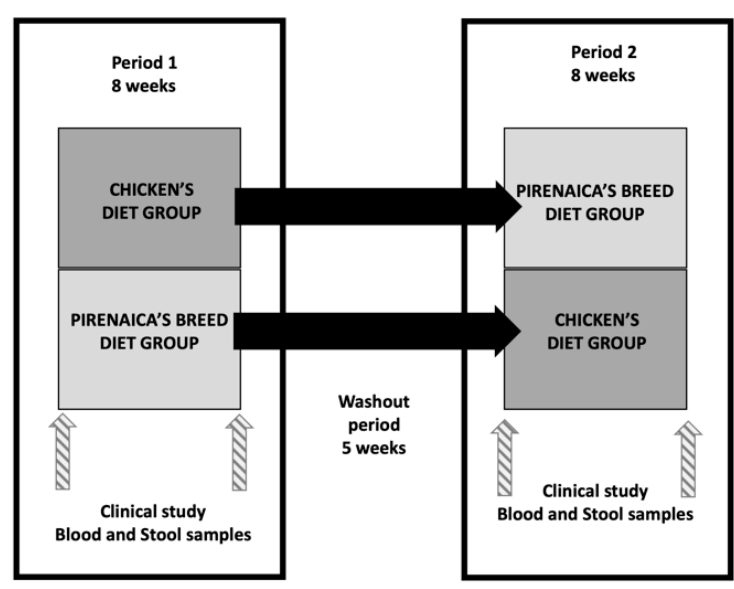
Figure 2. Study Figure 2. Study design.